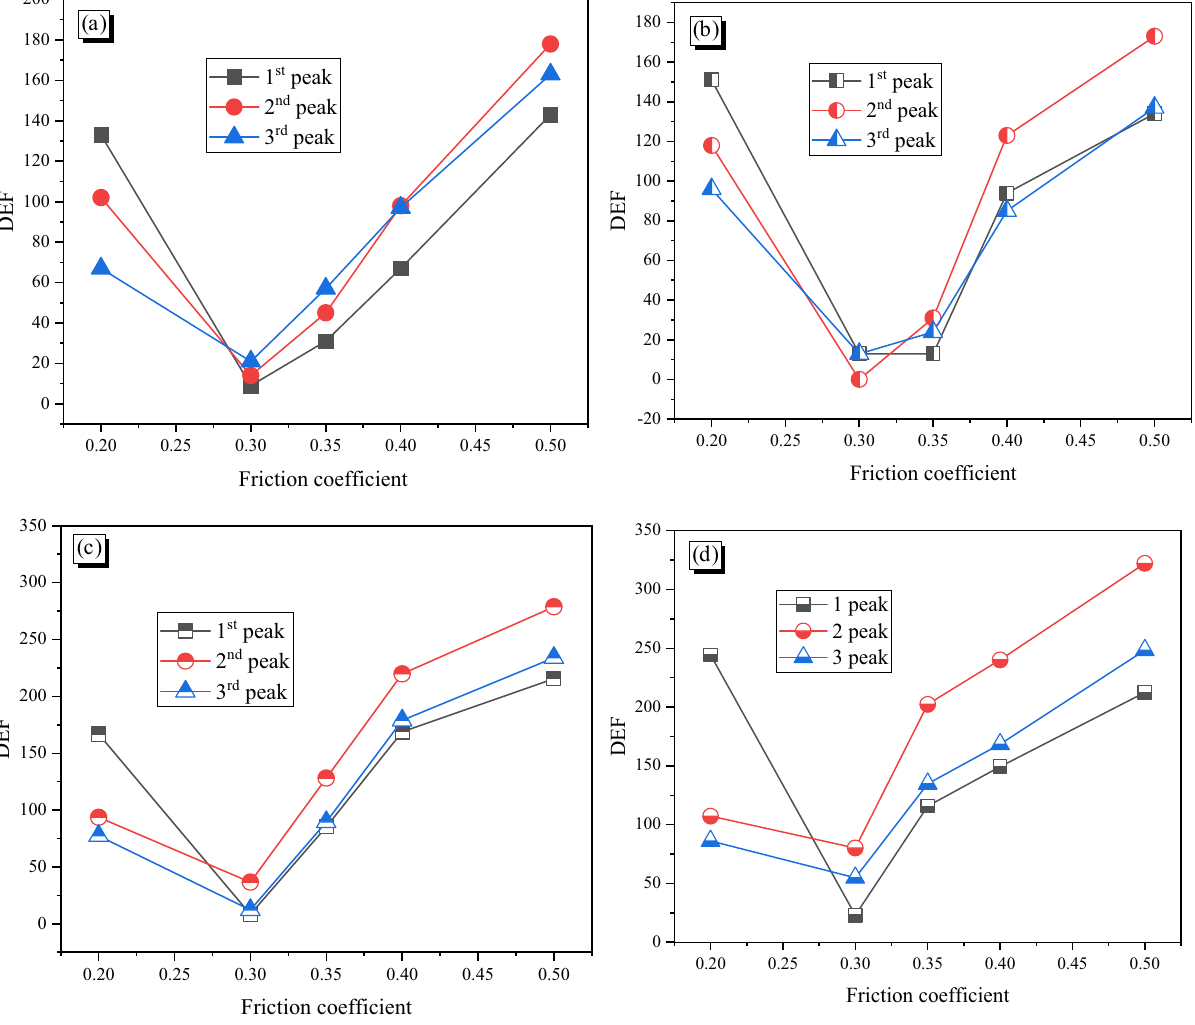
Figure 20: Relationship between DEF and friction coe ffi cient: ( a ) wave depth = 0.055 mm, ( b ) wave depth = 0.061 mm, ( c ) wave depth = 0.091 mm, and wave depth = 0.124